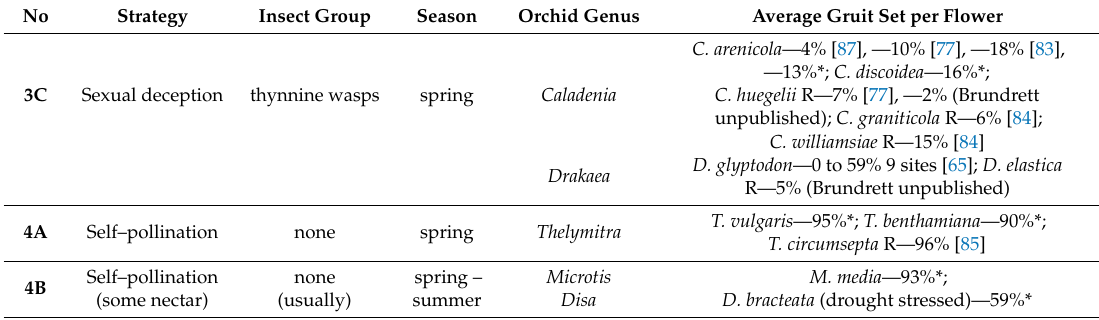
Table 2. Evidence that pollinator availability and behavior or resource limitations restrict